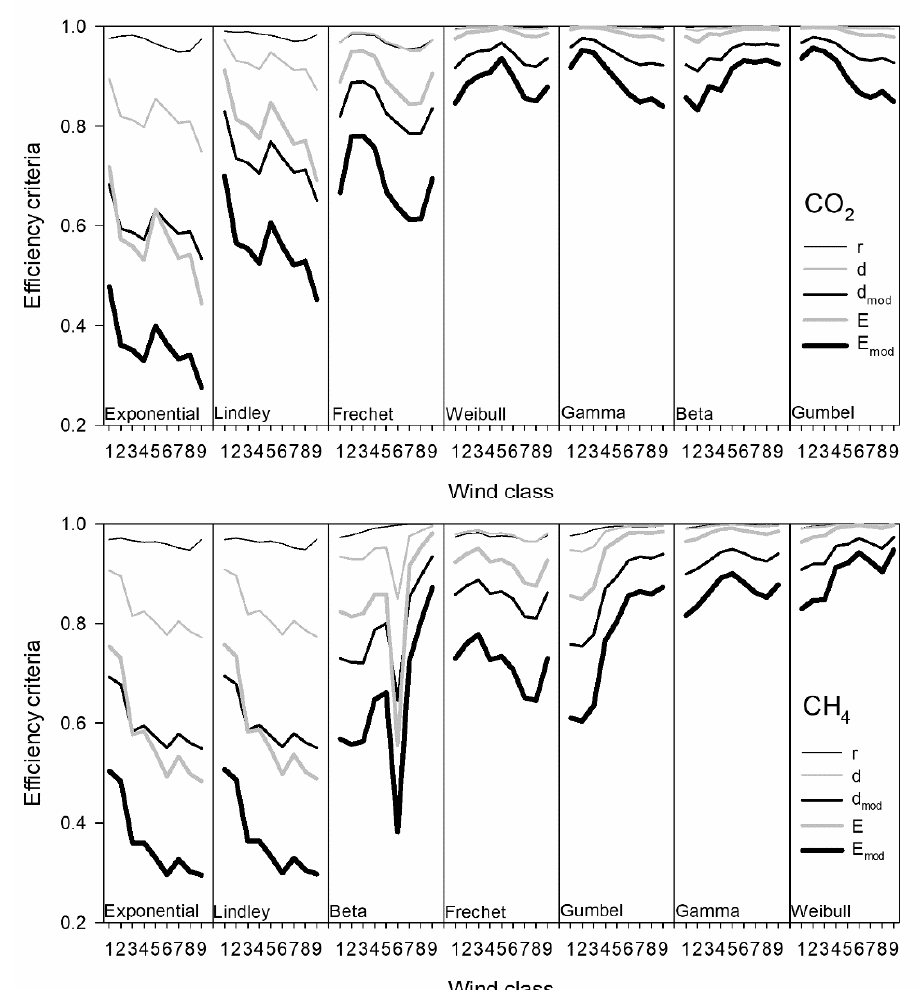
Figure 5. Distribution functions ordered following the efficiency criteria.